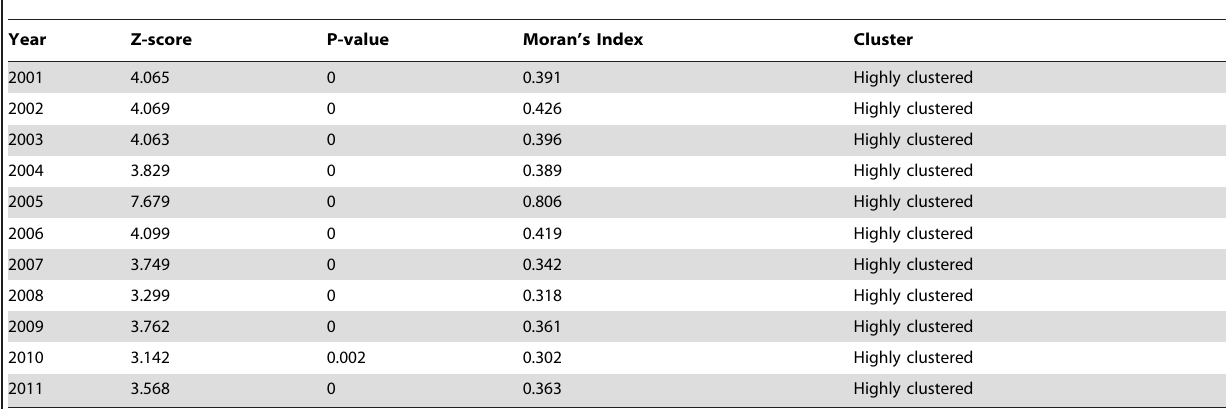
Table 1 . The results of the analysis on HFRS cases by general spatial